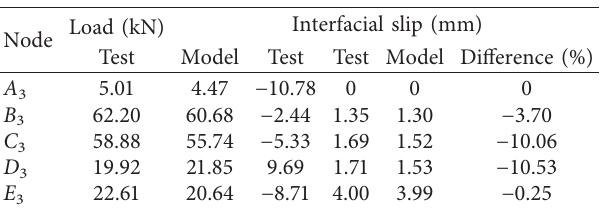
Table 8: Load-deflection curve and load-slip curve information of specimen CD-ERA-P- λ 3.33